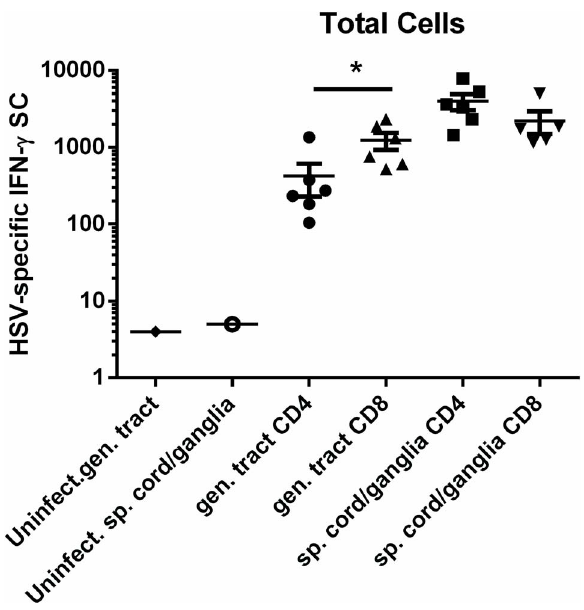
Fig. 7. Presence of CD4 + and CD8 + HSV-specific memory T cells in genital tracts and neural tissue of HSV-2 infected guinea pigs. Hartley guinea pigs were infected ivag with HSV-2 strain MS and lymphocytes isolated from the indicated tissues on days 99–150 post infection. Enriched populations of CD4 + and CD8 + T cells were obtained using a magnetic-based kit. HSV-specific, IFN- c SCs were detected and quantified by IFN- c ELISPOT. Each data point represents results from an individual animal. (* P , 0.05 Student’s t